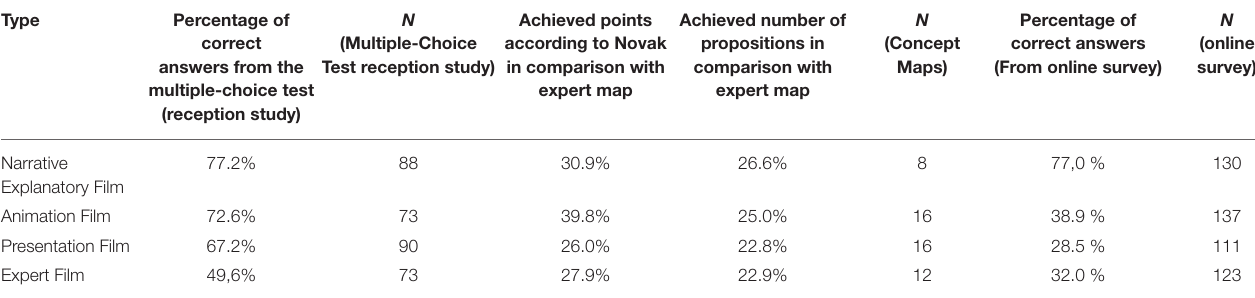
TABLE 1 | Results of all videos from both knowledge tests: multiple-choice and concept